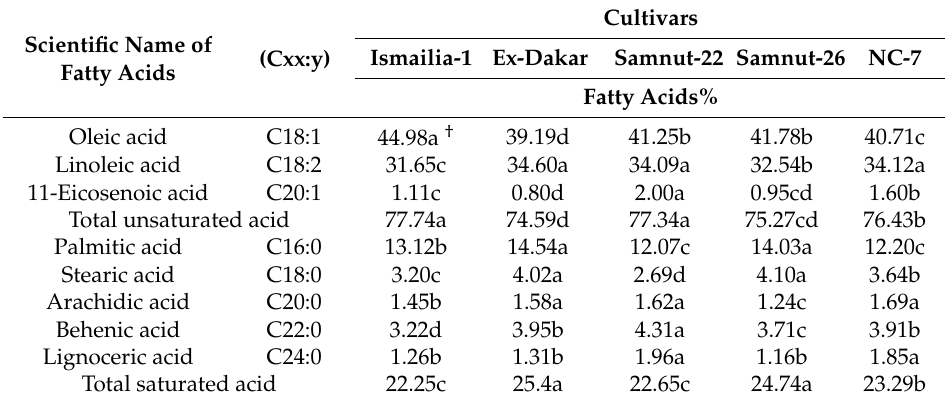
Table 5. Mean of fatty acids composition of seed oils produced by the cultivars tested at field experiments in Giza, Egypt—combined data from 2016 and 2017